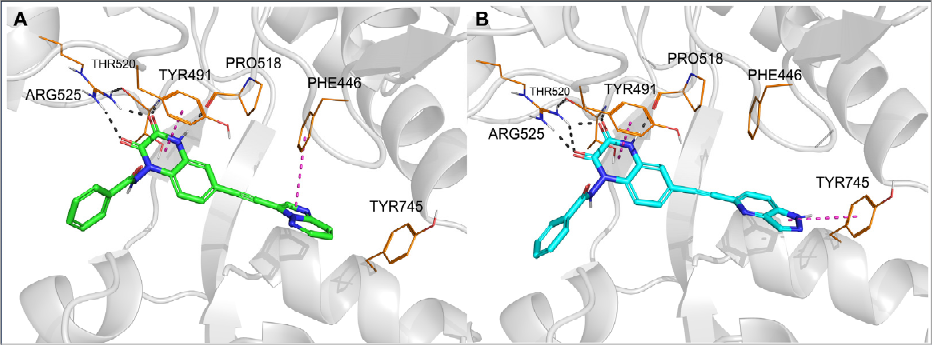
Figure 4. Top-ranked docking poses of 28 ( A ) and 29 ( B ) in the GluK3-LBD homology model. Hydrogen bonds are marked with gray dashes; π – π interactions are marked with pink dashes.